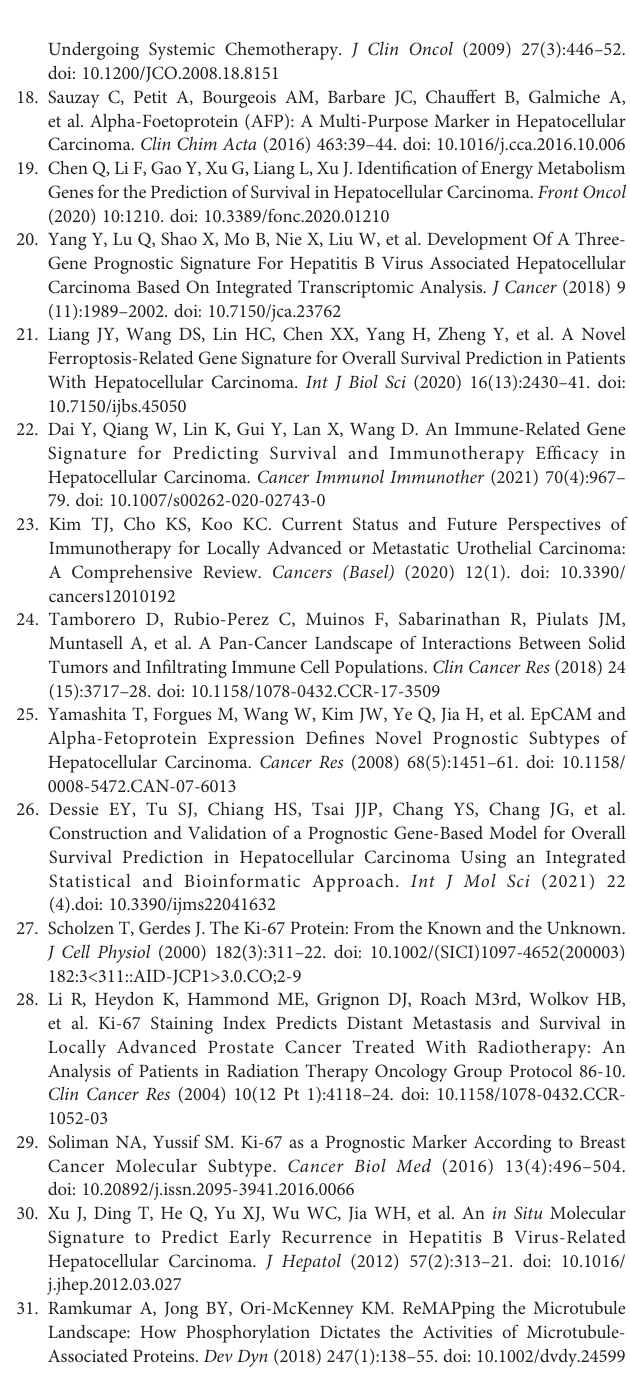
Supplementary Figure 7 | The GSEA diagram of GO biological processes. Supplementary Figure 8 | The GSEA diagram of KEGG pathways. Supplementary Figure 9 | The correlation of prognostic gene expression with drug resistance. MAP2. (B) DYNC1H1. (C) CPS1. (D) PTPRB. (E) MKI67. Supplementary Figure 10 | Prognostic gene expression between pan-cancers and para-cancerous